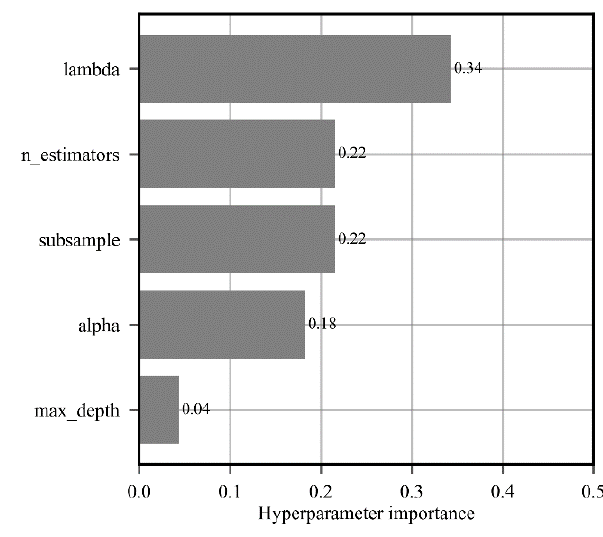
Figure 4. Hyperparameter importance of XGBoost.